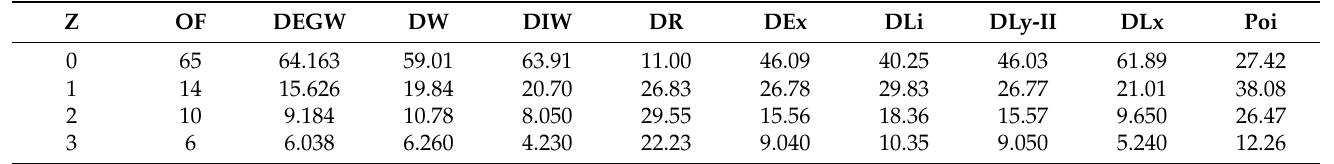
Table 18. The goodness-of-fit test statistics for comparing the competitive models for dataset